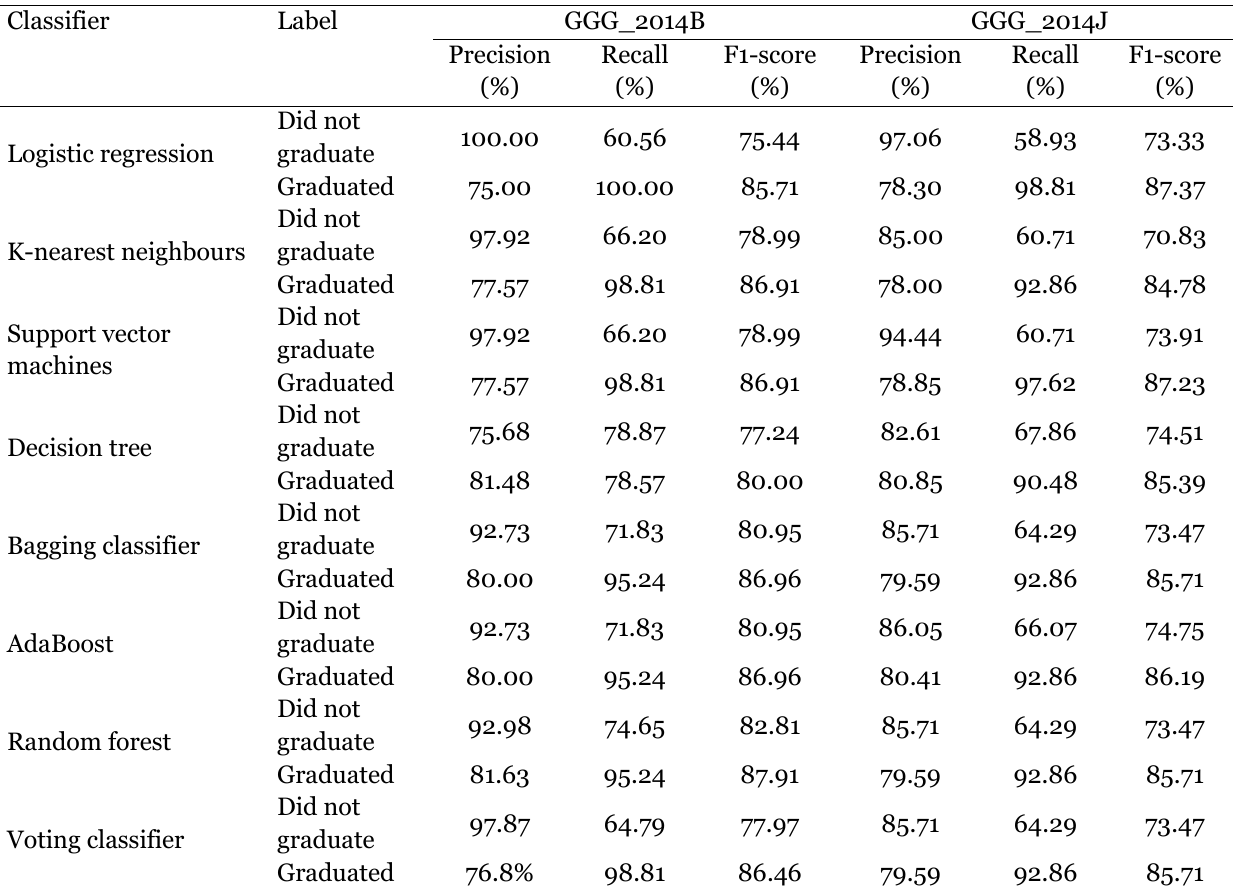
Classification Report for Predicting Performance in Course GGG with Virtual Resource